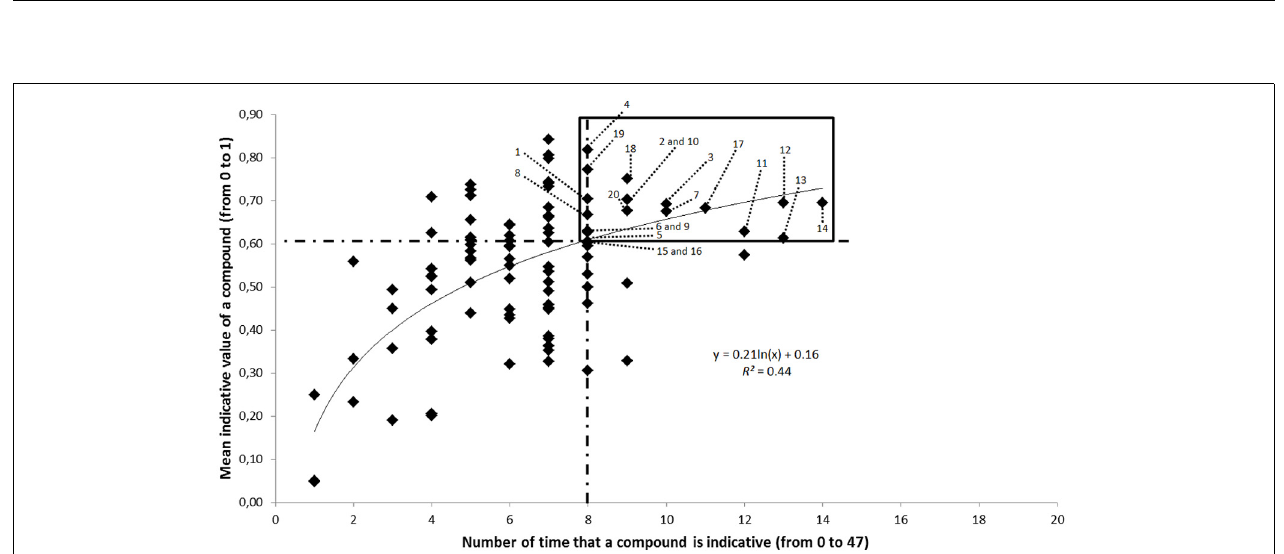
three MSP components) of abdomen, antennae, head, legs, wings and whole individuals, using nMDS ordination based on Bray-Curtis distance.